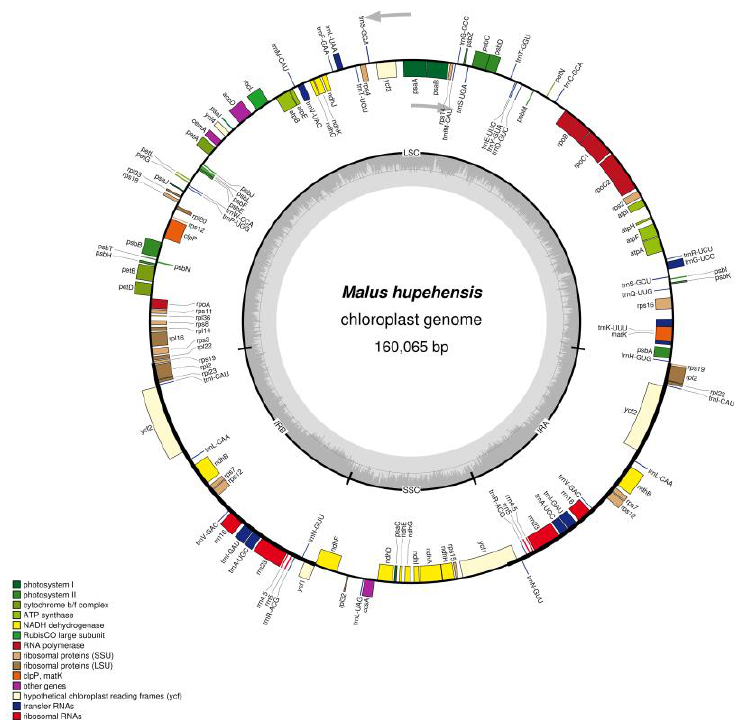
Figure 1. Gene map of the M. hupehensis chloroplast genome. Genes shown outside the outer circle are transcribed clockwise and those inside are transcribed counterclockwise. The colored bars indicate different functional groups. The dark gray inner circle corresponds to the GC content, the light-gray to the AT content.